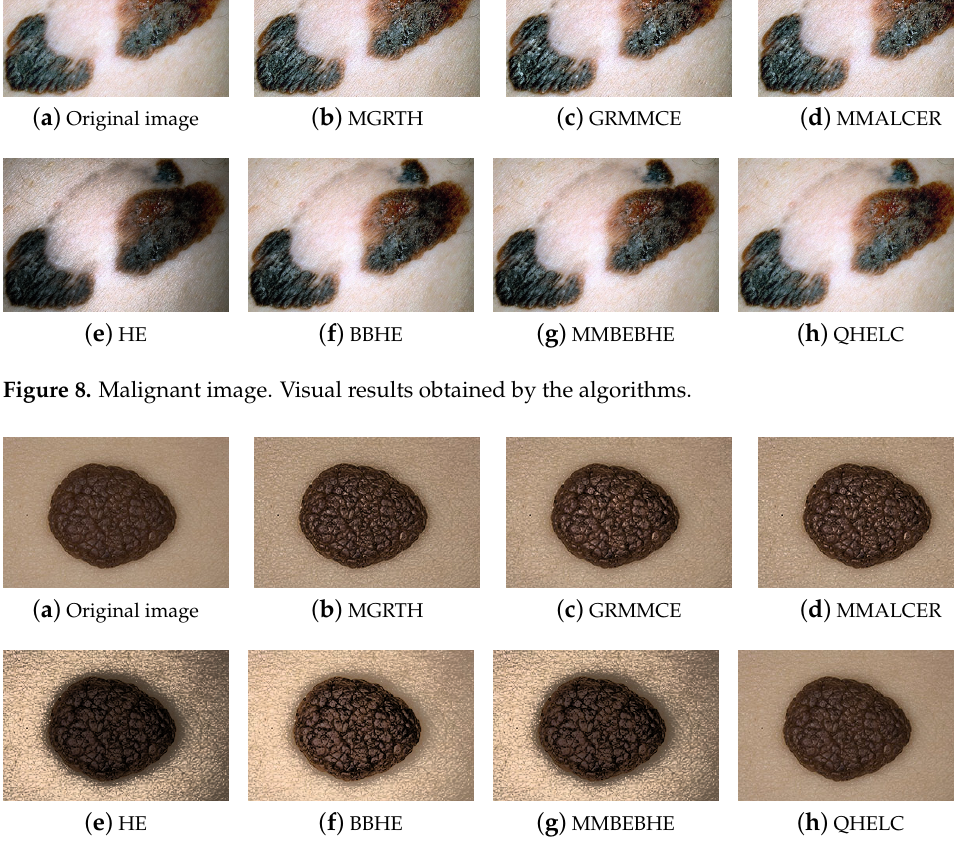
Figure 9. Benign image. Visual results obtained by the